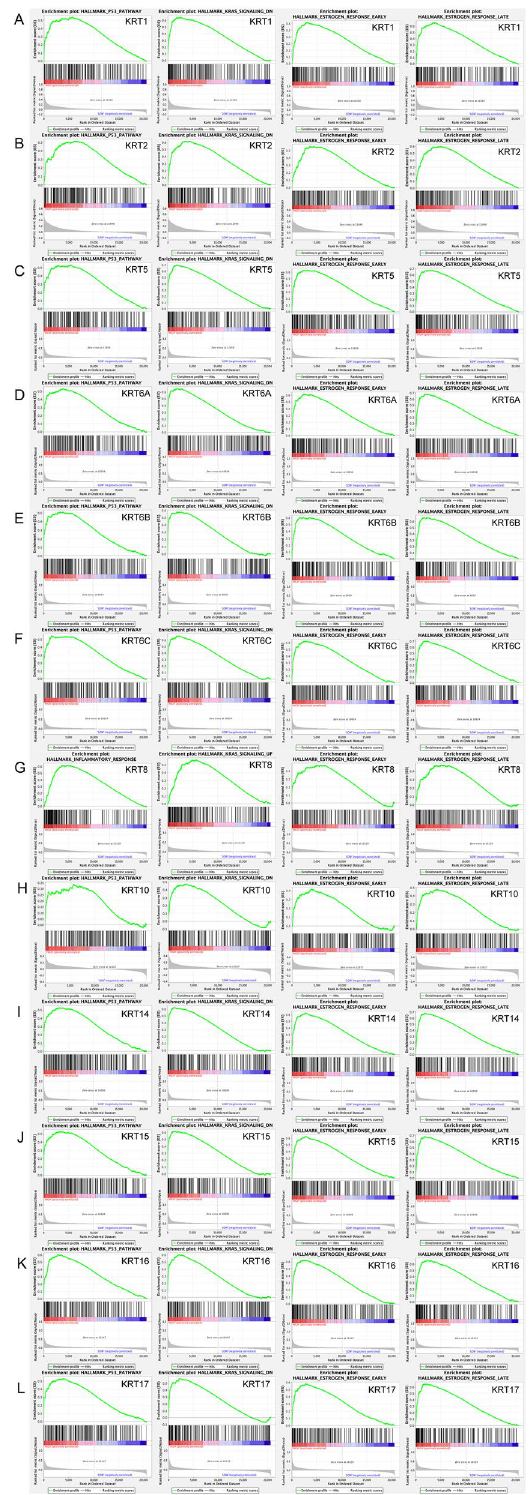
Figure 8. GSEA was used to perform hallmark signaling analysis in KRTs , respectively. A total of 100 significant genes were obtained from GSEA with positive and negative correlation. GSEA analysis, including KRT1, KRT2, KRT5, KRT6A, KRT6B, KRT6C, KRT10, KRT14, KRT15, KRT16 and KRT17 indicated that the most involved hallmarks pathways were P53 pathway, KRAS signaling, estrogen response early and estrogen response late; whereas the most involved hallmarks of KRT8 were inflammatory response, KRAS signaling, estrogen response early and estrogen response